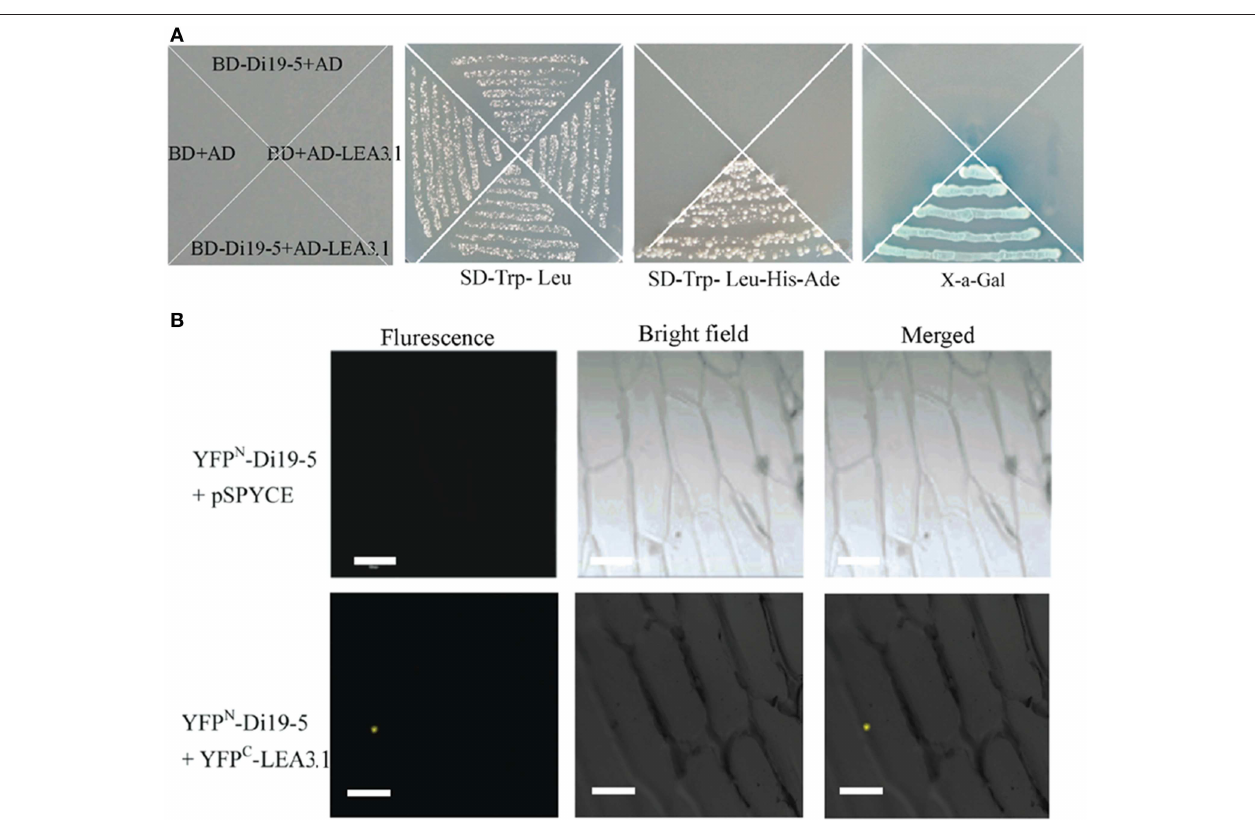
FIGURE 8 | Interaction of GmDi19-5 with GmLEA3.1. (A) Yeast two-hybrid interaction assay. Vectors were co-introduced into yeast in different combinations: 1, pGADT7 and pGBKT7; 2, pGBKT7-GmDi19-5 and pGADT7; 3, pGBKT7 and pGADT7-GmLEA3.1;